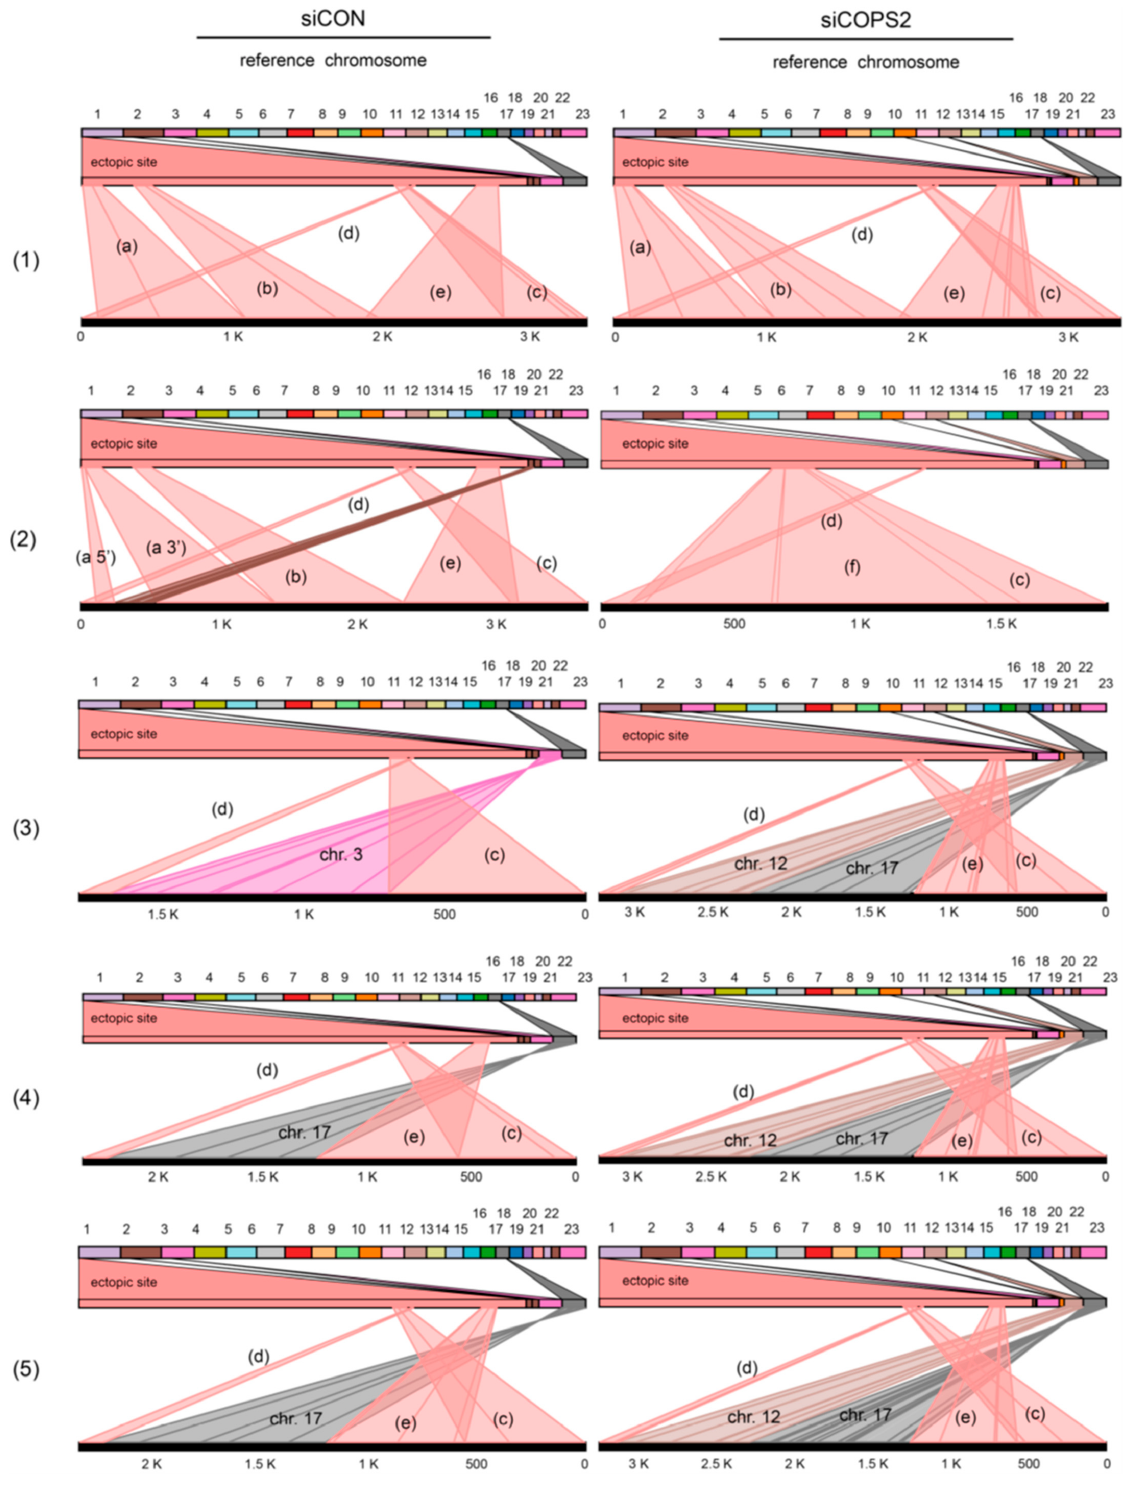
Figure 12. COPS2 knockdown increases template switching. Template switching in DF/myc(ATTCT) 47 cells treated with siCON (left) or siCOPS2 (right). Reference chromosomes are shown at the top. Segments of the ectopic site engaged in template switching extend from the wedge below the reference chromosomes. Template switching domains (a)–(f) are as in Figure 11. Darker lines within a domain indicate indels. The black bar at the base of each diagram represents the sequence read. Lines (1)–(5) in Figure 12 refer to lines (1)–(5) in Figure